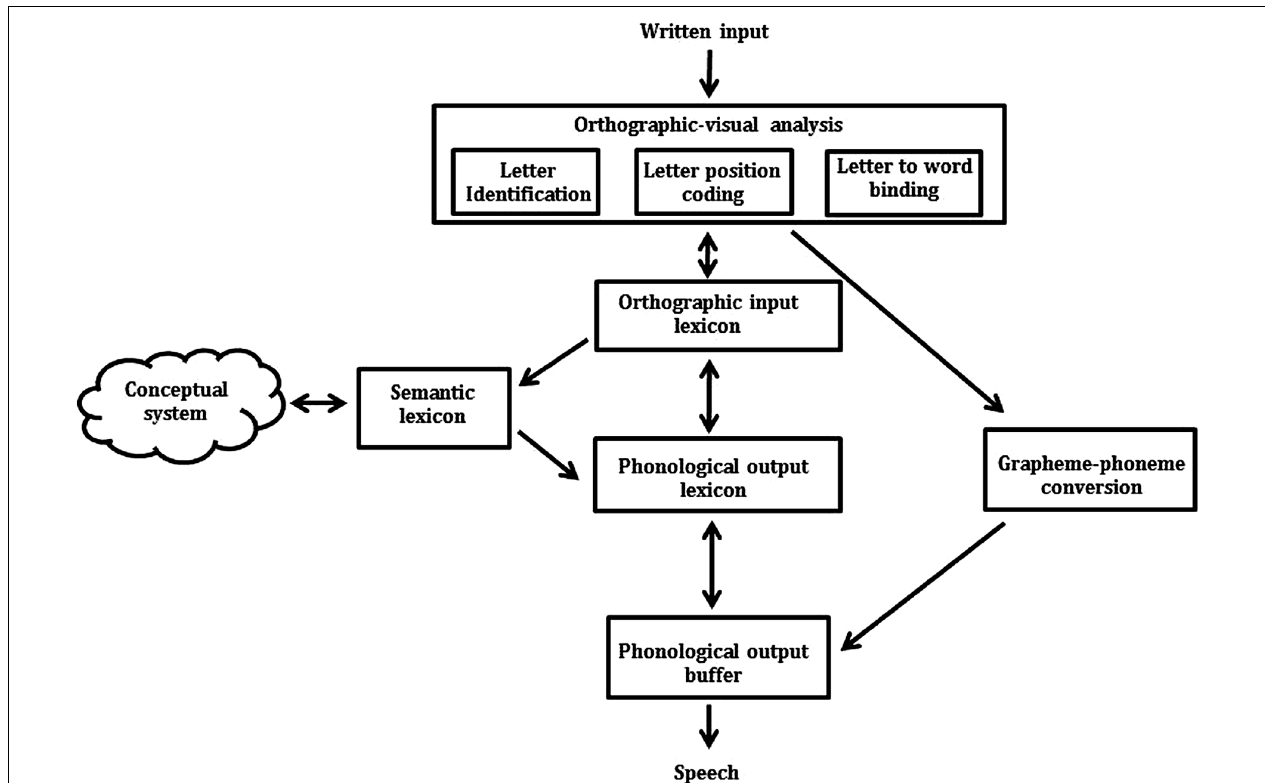
FIGURE 1 | A cognitive model of reading aloud (e.g., Friedmann and Rahamim, 2007; Kohnen etal., 2012) detailing the three reading routes: (1) the lexical route (orthographic input lexicon to phonological output lexicon), (2) the lexical-semantic route